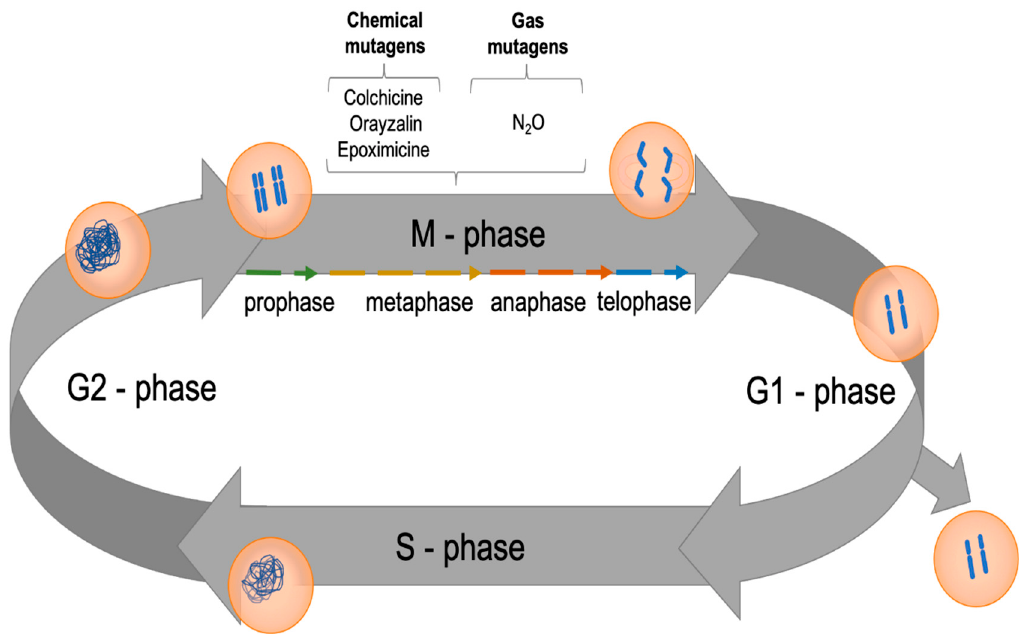
Figure 3. Action of anti-mitotic agents in the plant cell cycle for inducing polyploidy. Mutagenic agents such as colchicine, oryzalin, nitroxide, and epoxomicin have been used for polyploidy induction in plants. The most frequently applied is colchicine, although it sometimes has undesirable side effects, including sterility, abnormal growth, chromosomal rearrangement or reduction, and gene mutation [37,42–45]. Various explants, such as lateral buds, leaflets, nodules, small branches, tuberous and rhizome fragments, seedlings, sexual or somatic embryos, calli, and cell suspension cultures, have been treated with anti-mitotic agents to generate polyploid plants. During in vitro induction, the culture media can be solid, semi-solid, or liquid, depending on the plant species and anti-mitotic agent. The duration of the treatment also depends on the anti-mitotic agent used, the plant species, the culture medium, and the explant size and type [37–45].